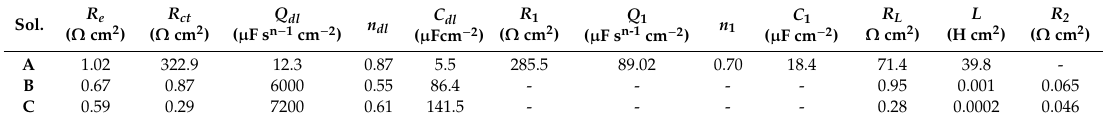
Table 3. Electrochemical parameters of Zn dissolution in di ff erent bromide-containing electrolytes. Sol.